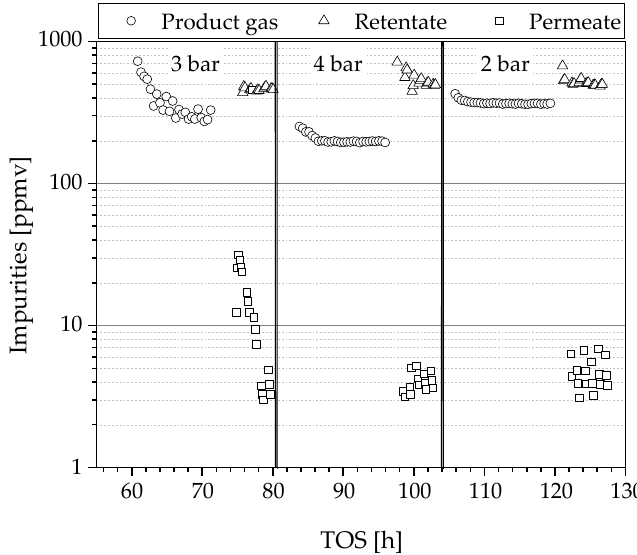
Figure 11. Impurities of the product gas, retentate and permeate measured by GC in ppmv and logarithmic form over the time on stream.